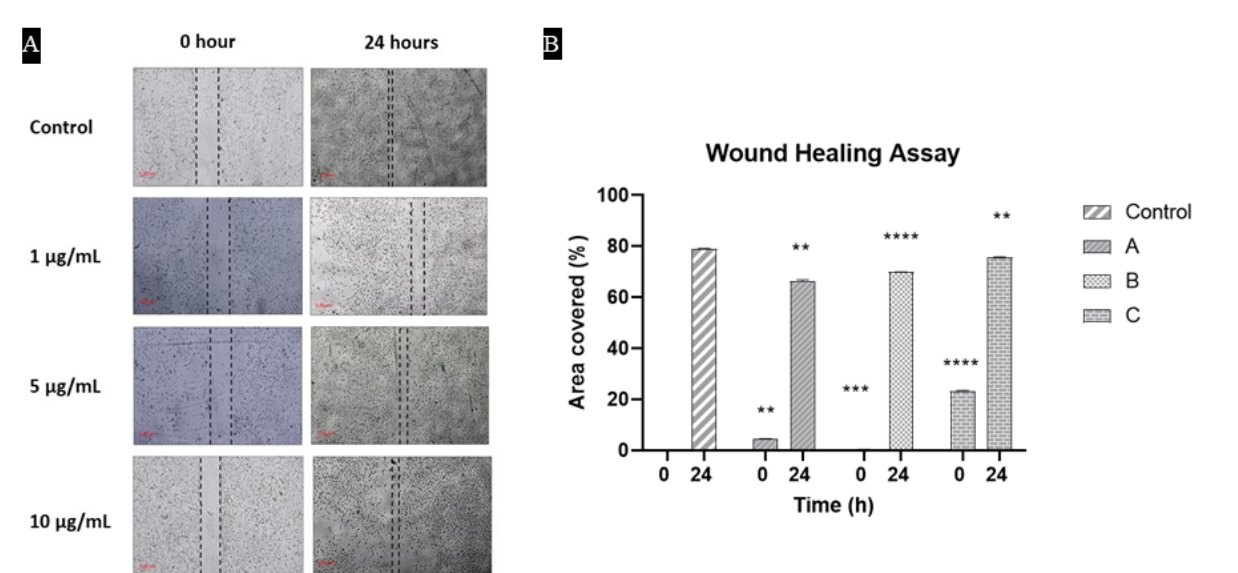
Figure 8. The migration rate of NIH3T3 cells determined by a scratch wound assay where ( A ) rep- resents the microscopic images of migrating cells in different groups while ( B ) is the bar graph rep- resenting the migration rate in each group. Each bar indicates the mean of area covered when com- pared with the control.